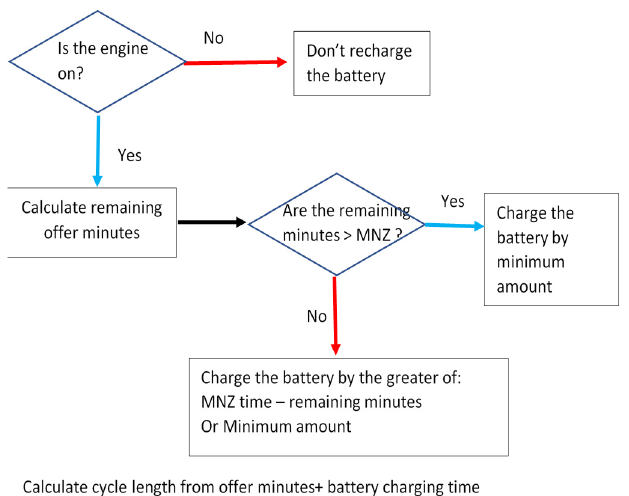
Figure 6. Calculate operation cycle.